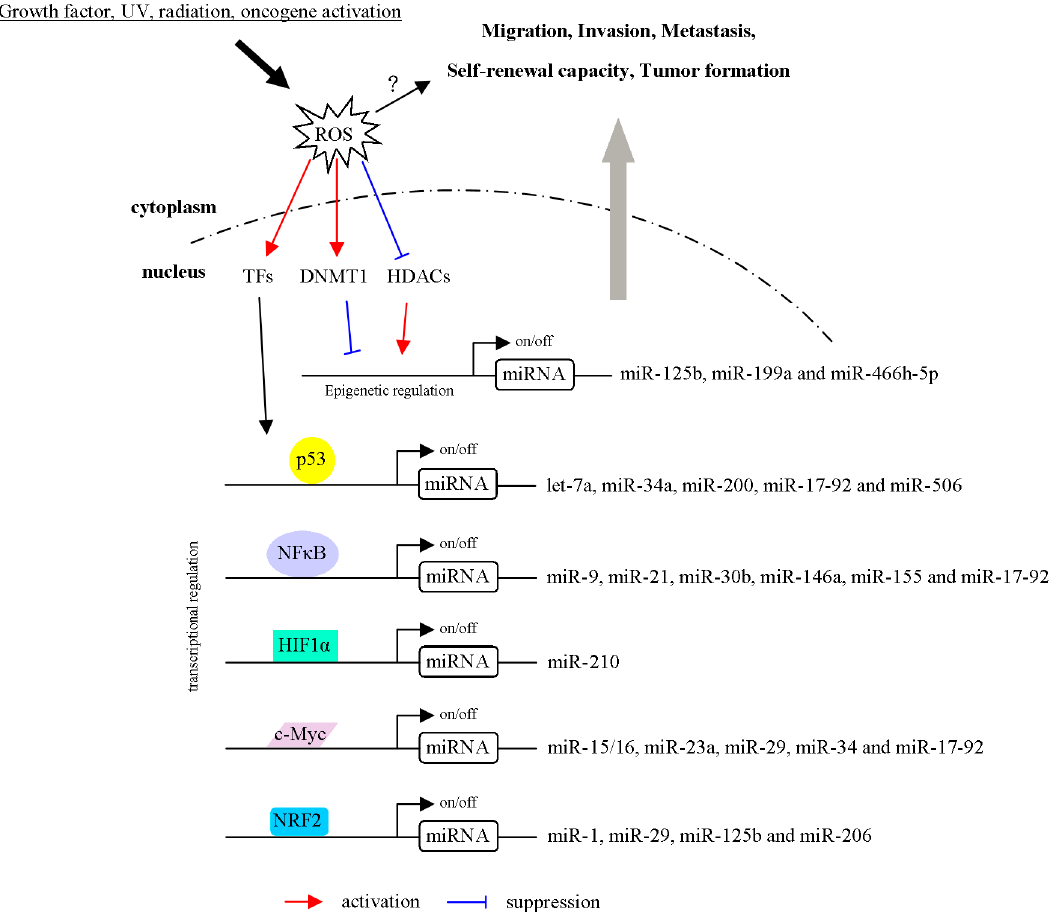
Figure 3. Schematic model showing mechanisms in which ROS regulates the biogenesis and transcription of miRNAs. ROS activate or inhibit epigenetic, transcriptional regulations of miRNA expression. For example, miRNAs are regulated by ROS through modulation of chromatin remodeling factors (DNMT1 and HDACs). In addition, ROS induces or represses transcriptional factor (p53, NF κ B, HIF1 α , c-Myc and NRF2) to regulate miRNA expressions. Furthermore, ROS / TF / miRNA axis controls cell migration, invasion, metastasis, self-renewal capacity and tumor formation.